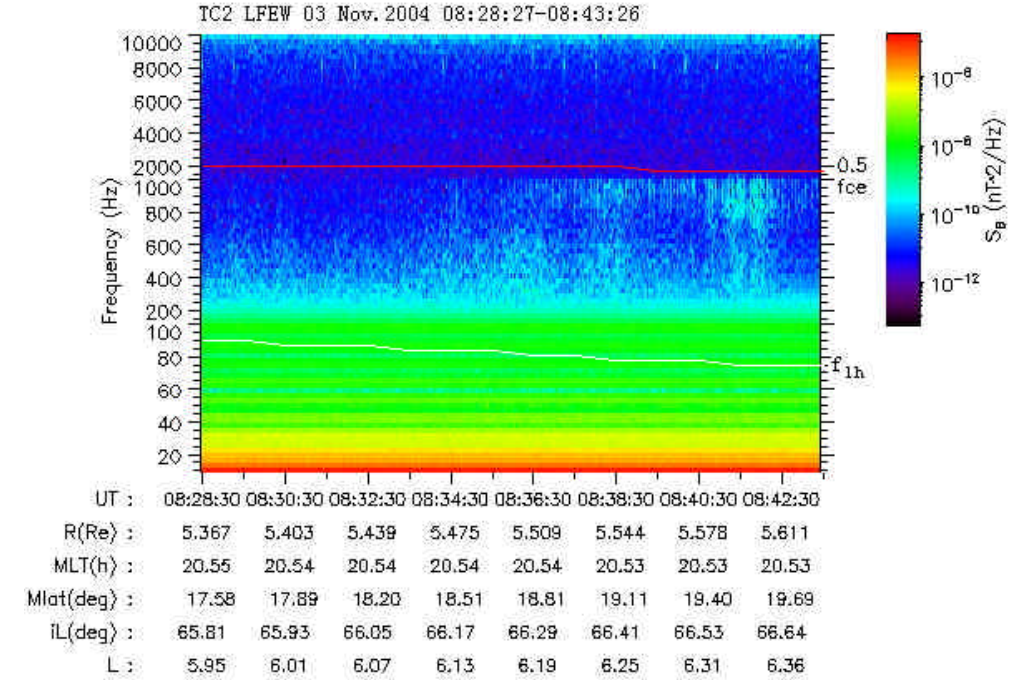
Fig. 7 The time frequency spectrum observed by LFEW at 08:28:30-08:43:30 on Nov.3, 2004 Fig. 7. The time frequency spectrum observed by LFEW at 08:28:30–08:43:30UT on 8 November 2004.